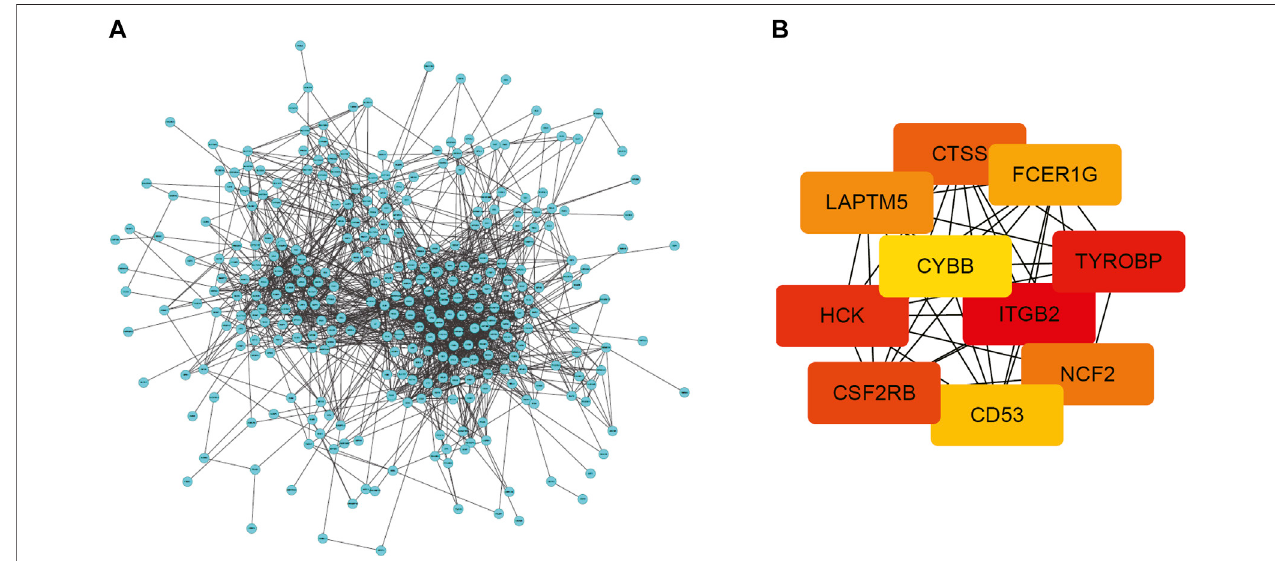
FIGURE 4 | PPI network of DEGs and top 10 hub genes. (A) PPI network of DEGs created by STRING. Circles represent genes and lines represent PPIs (B) The network of the top 10 hub genes identi fi ed by MCODE. DEG: differentially expressed gene; PPI: protein – protein interaction.